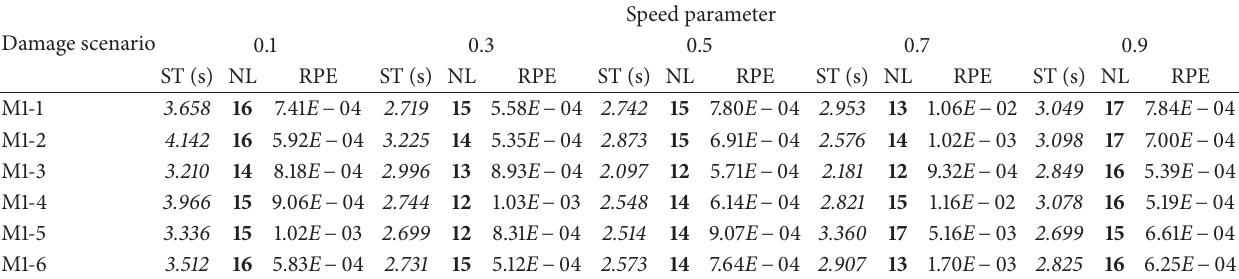
Table 3: Solution time, number of loops, and RPE of ADM method for model 1.